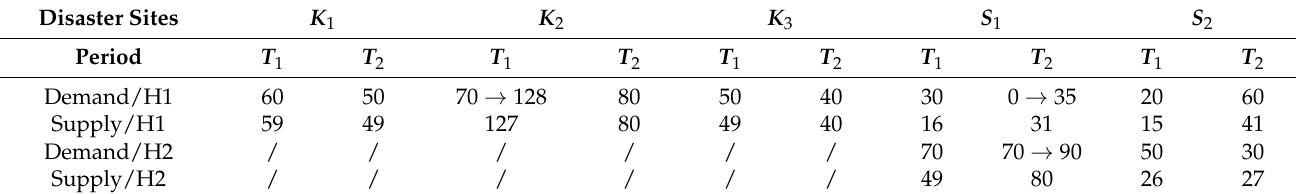
Table 4. Allocation of emergency resource under changes in supply and demand ratios.